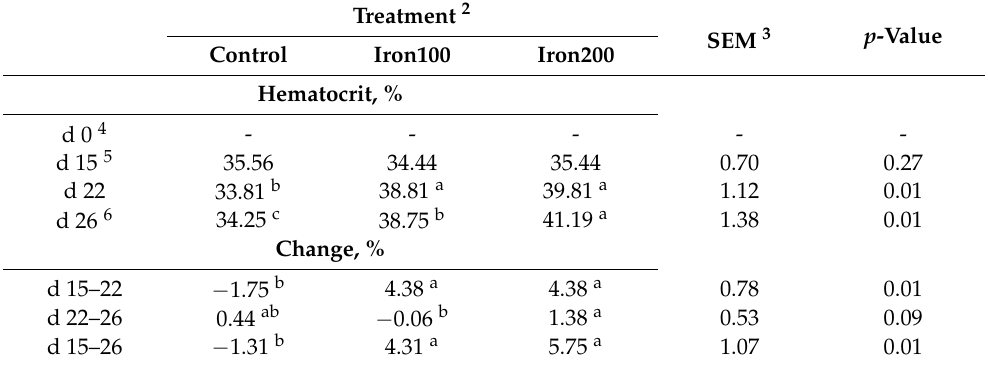
Table 2. Hematocrit level of pigs injected with additional iron before weaning in Experiment 1 1